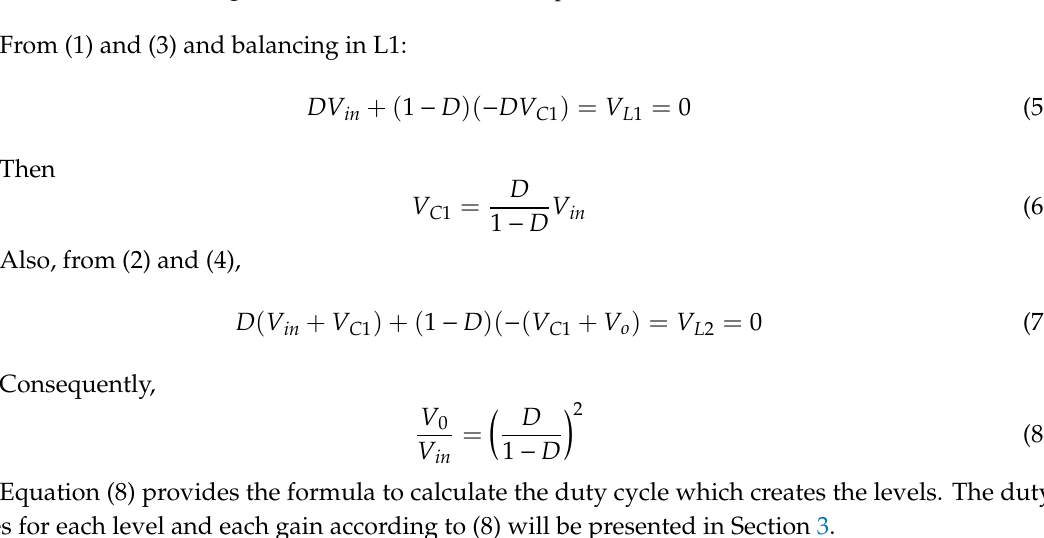
Figure 4. The behaviors of the components for two